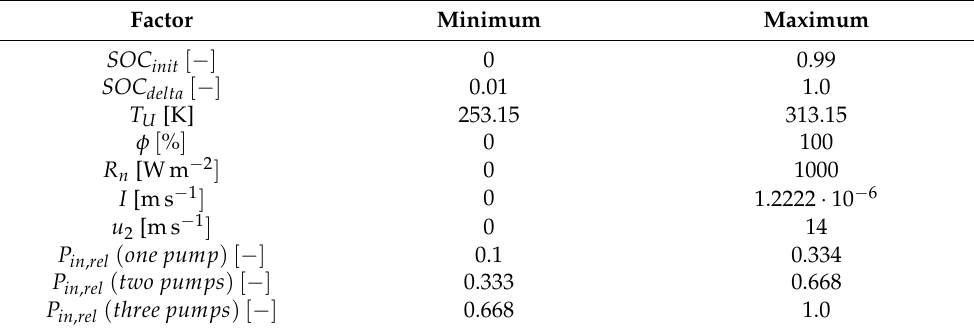
Table 3. Factors with corresponding limits used in the experimental